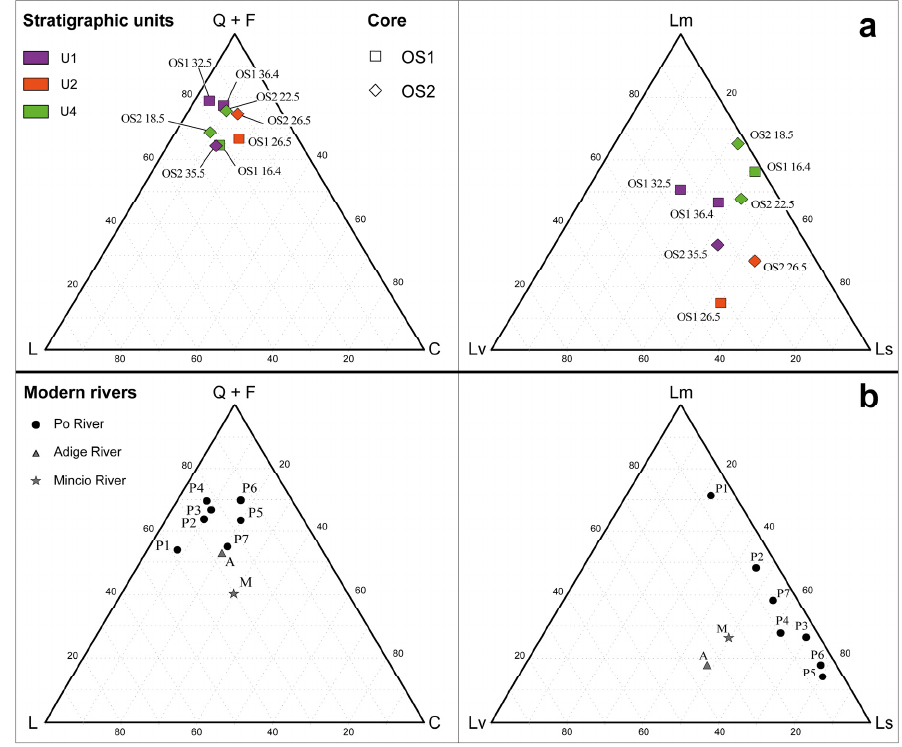
Figure 5. Composition of sands from Ostiglia cores and modern rivers. Ternary diagrams showing composition of sands from cores OS1 and OS2 ( a ) and from modern rivers ( b ). Q + F: quartz and feldspar; L: siliciclastic lithics; C: carbonate lithics; Lm: metamorphic lithic; Lv: volcanic lithic; Ls: sedimentary